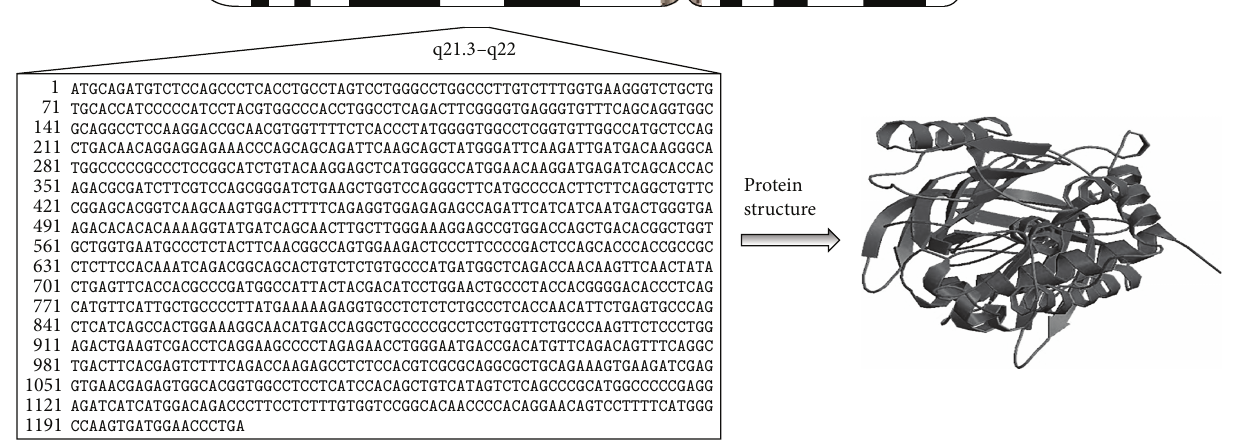
Figure 2: Genetic loci and protein structure of